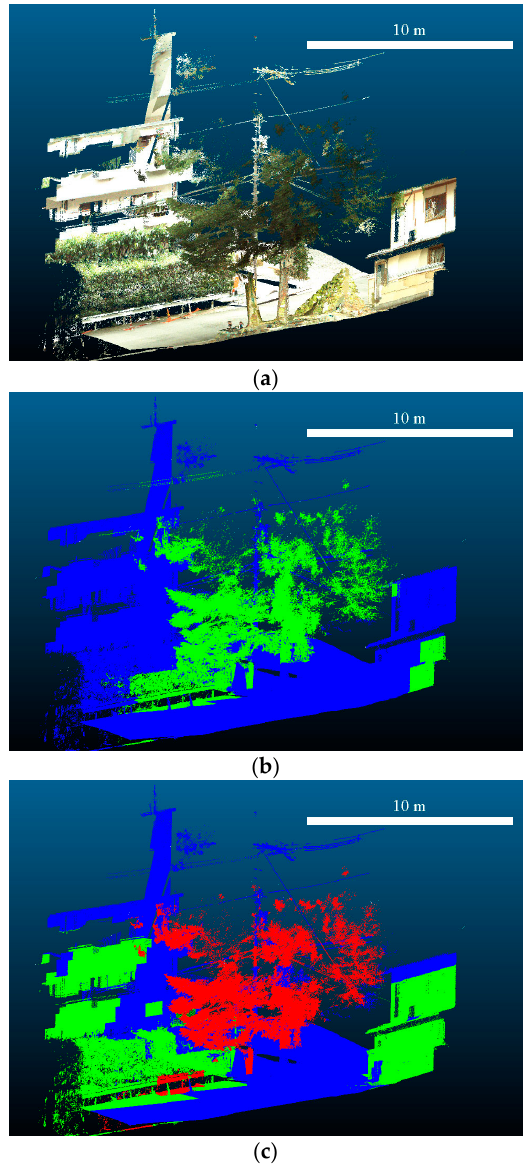
Figure 8. Improvement of extracting vegetation based on a multi-spatial-scale approach: ( a ) colored point cloud; ( b ) vegetation extracted with σ 11 = 0.5 m, σ 12 = 1.0 m, σ 21 = 1.0 m and σ 22 = 2.0 m; and ( c ) vegetation extracted with σ 11 = 1.0 m, σ 12 = 2.0 m, σ 21 = 2.0 m and σ 22 = 4.0 m. ( b , c ) Red and green denote vegetation extracted in the first and second loop, respectively, and blue denotes non-vegetation.